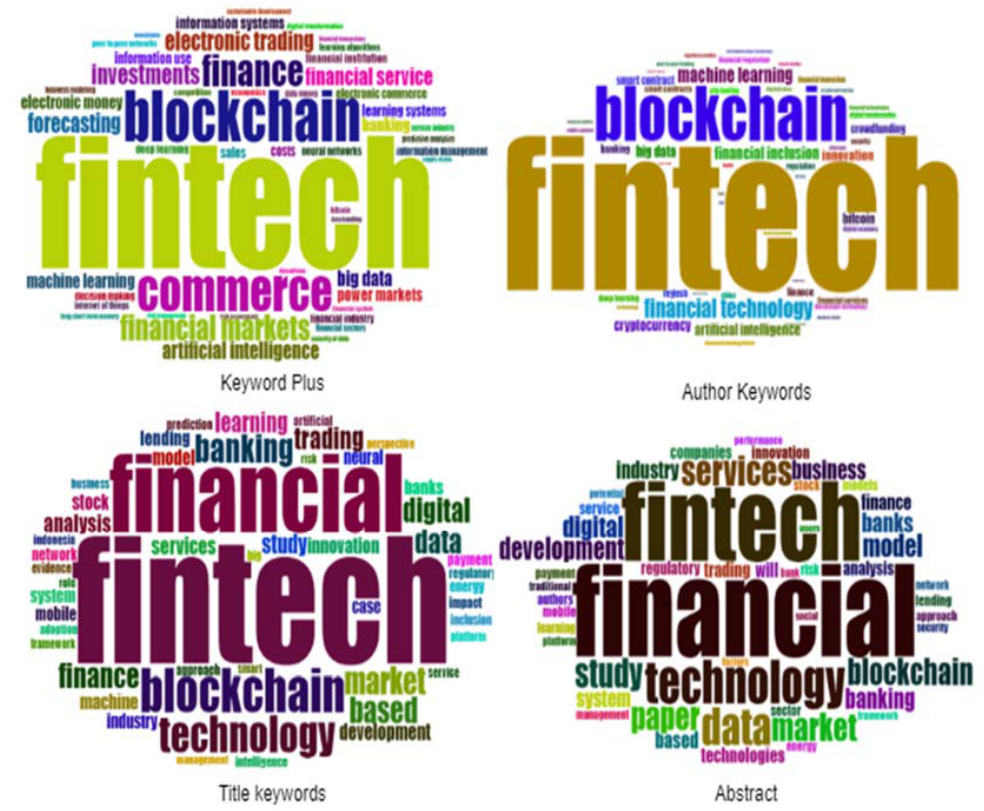
Figure 6. Word clouds. Table 5. Research stream of Fintech